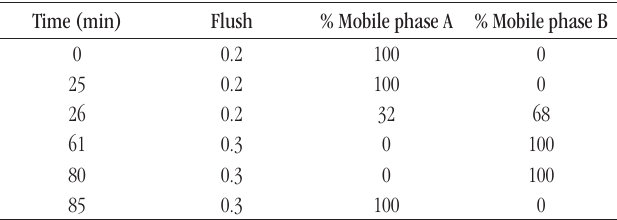
taBLE 2 − Mobile phase gradient established by amino acid